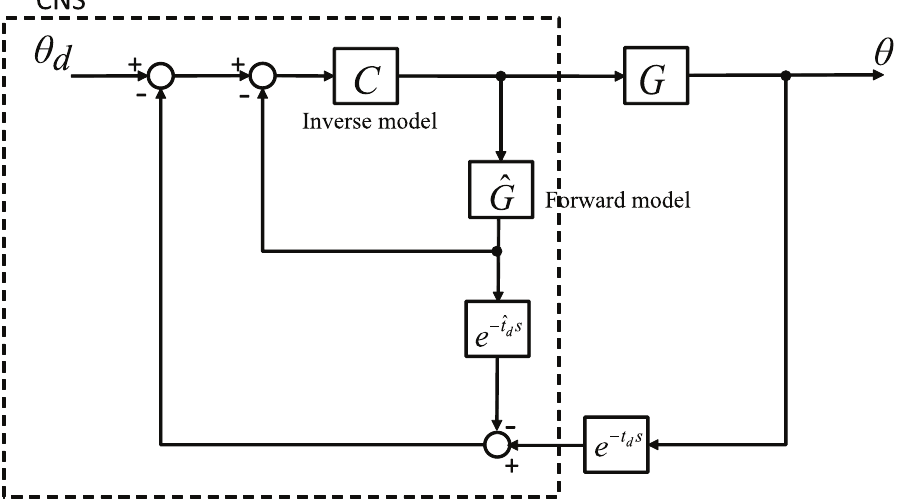
Fig 2. Smith predictor. The Smith predictor is a model-based controller developed for processes with a long time delay in feedback loops. This control intentionally delays the estimated state as long as the actual state is delayed so that the delayed actual state and delayed estimated state cancel one